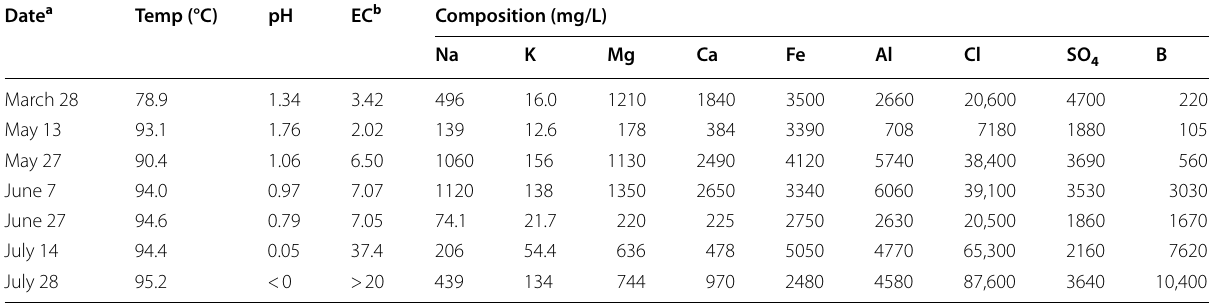
Table 2 Chemical composition of mud pool water formed in the 15-1